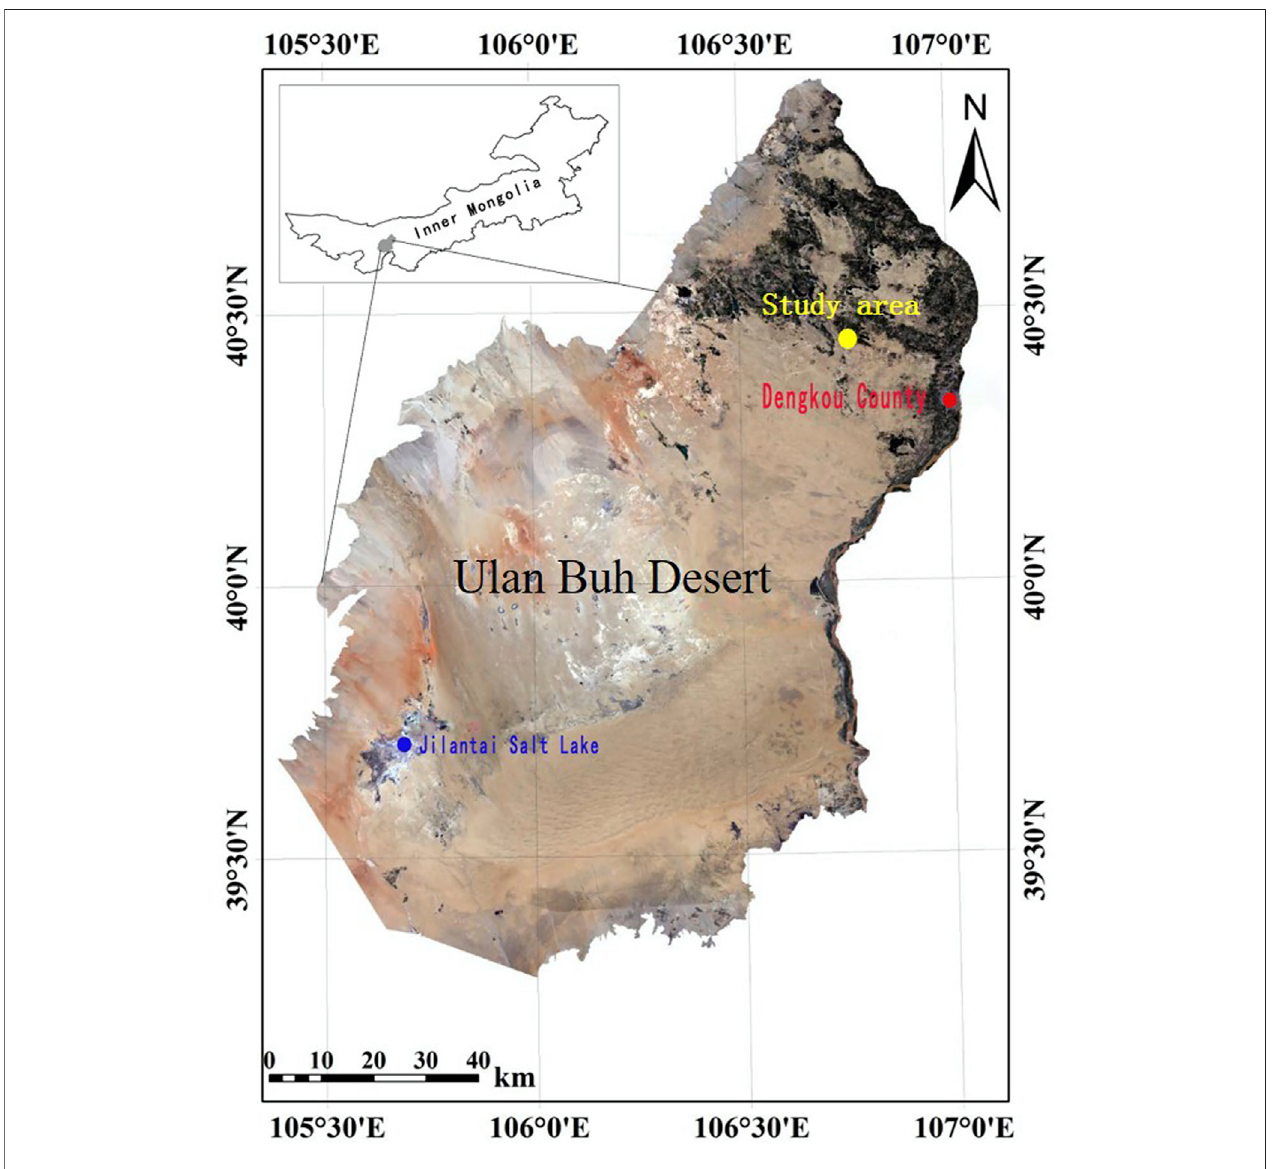
FIGURE 1 | Location of the study area.